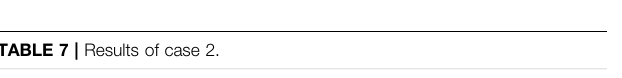
TABLE 7 | Results of case